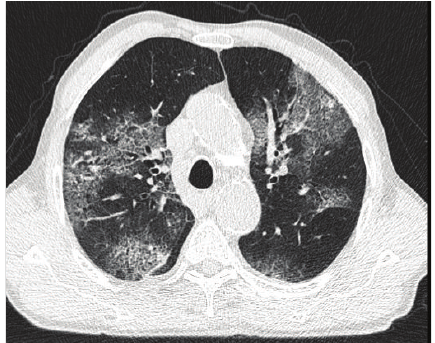
Figure 1: Chest CT scan done during the first admission showing bilateral patchy asymmetric interstitial lung disease suspicious of allergic alveolitis or eosinophilic pneumonitis.